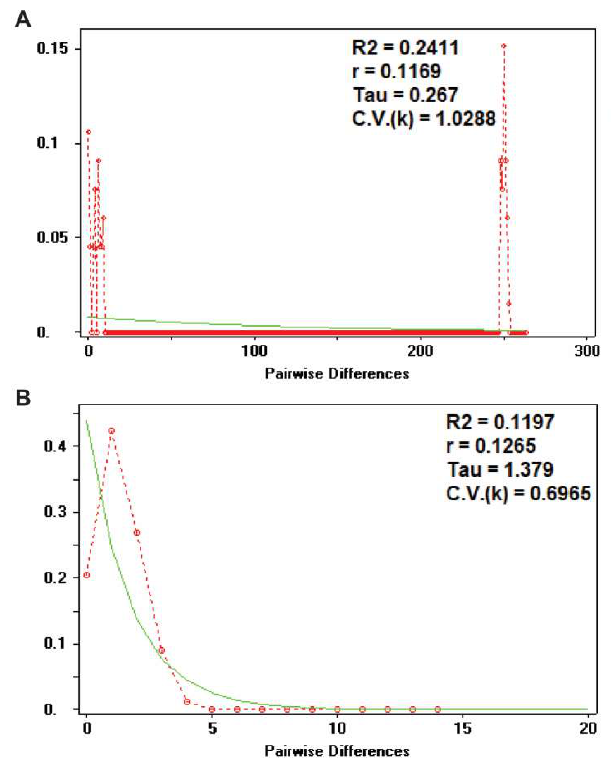
Figure 5. Pairwise nucleotides differences for Tamarixia radiata of COI ( A ) and wsp ( B ) gene sequences for the mismatch distributions; the solid lines show expected frequency distribution, while dotted lines show the distribution observed under the sudden-expansion model. R2 = Ramos-Onsins and Rozas statistics; r = Raggedness statistic; Tau = date of the growth; C.V.= coefficient of variation.